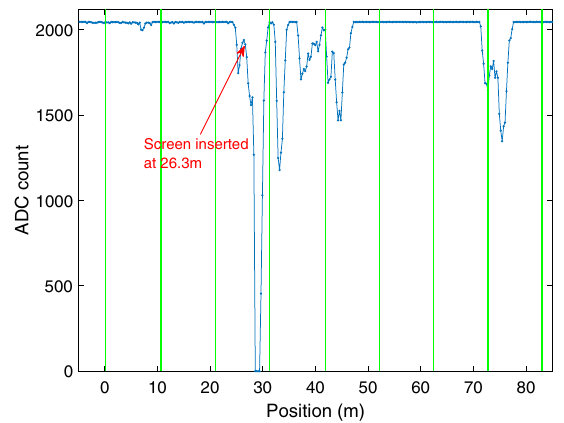
FIG. 7. Example PMT signal of an LLM, showing the detected beam loss when a screen is inserted. This signal is digitized and divided in up to 8 ROIs (areas between the green lines). The signal processing for each region is identical to the one for the